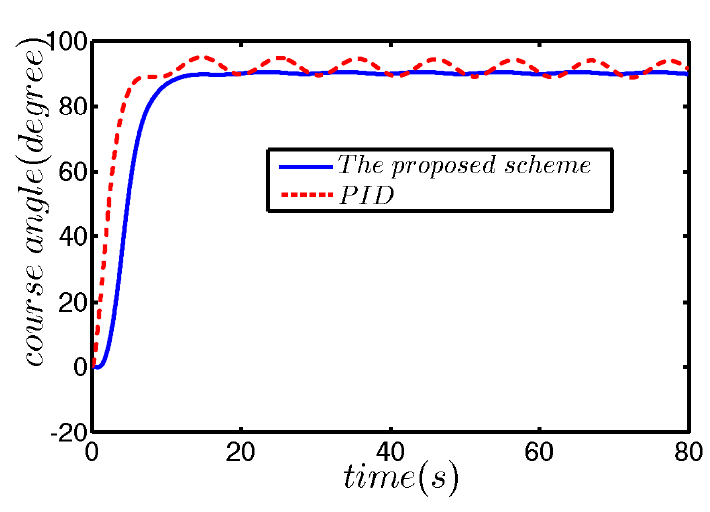
Figure 7. The curves of course angle under strong disturbance.